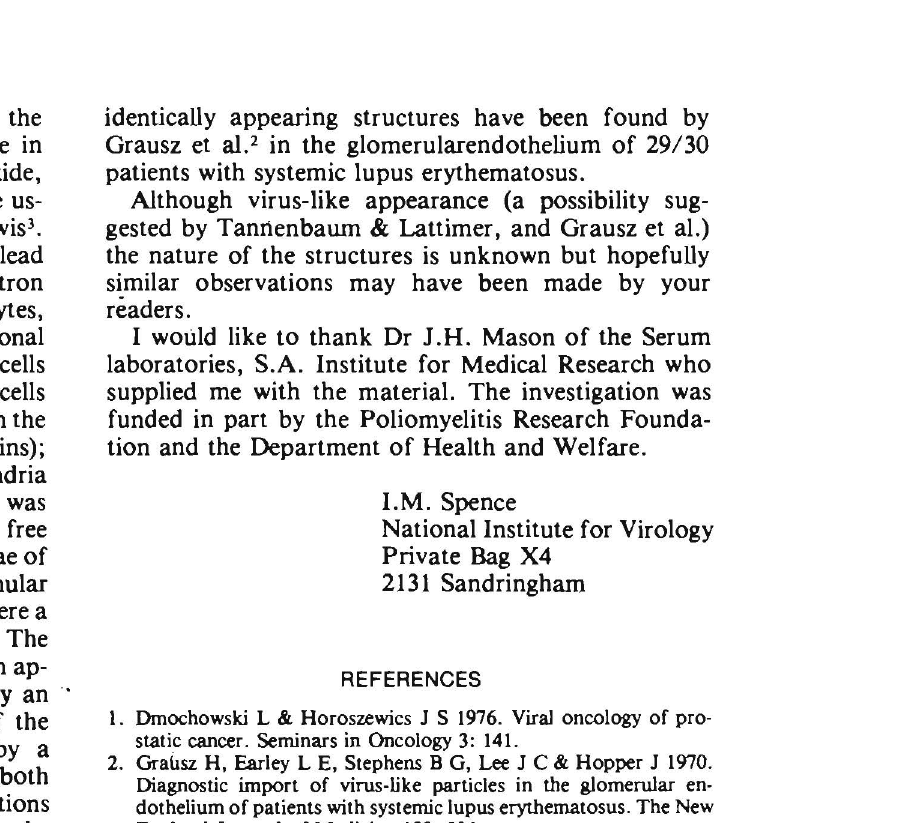
Fig. 2. Tubular elements showing limiting membrane (i) x